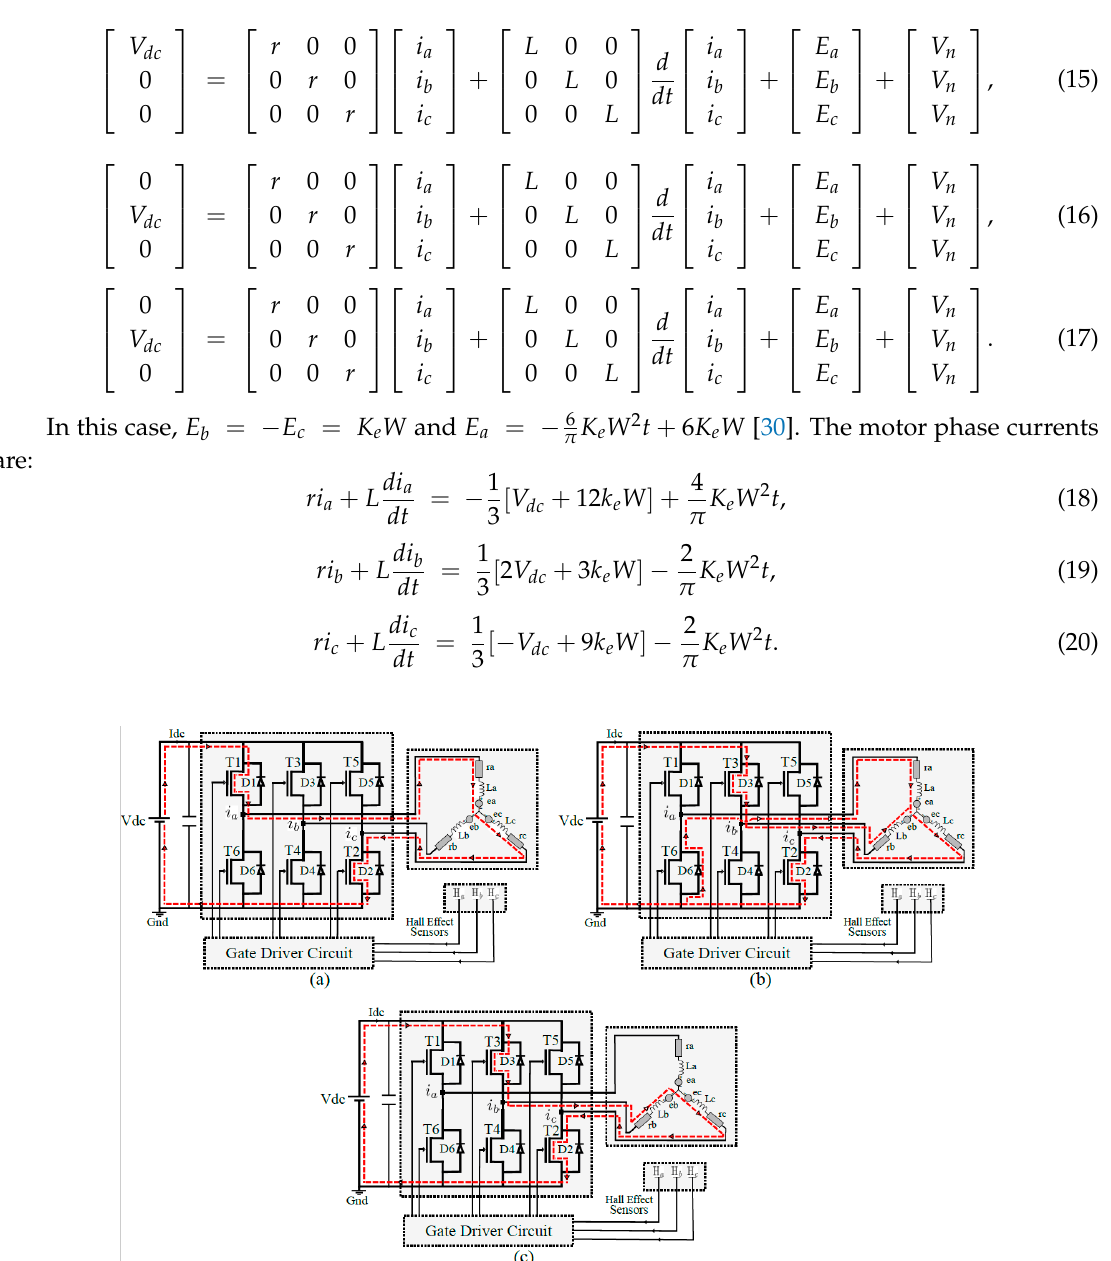
Figure 5. MOSFET states for upper-bridge current commutation: ( a ) Before the commutation interval, ( b ) during the commutation interval, and ( c ) after the commutation interval.